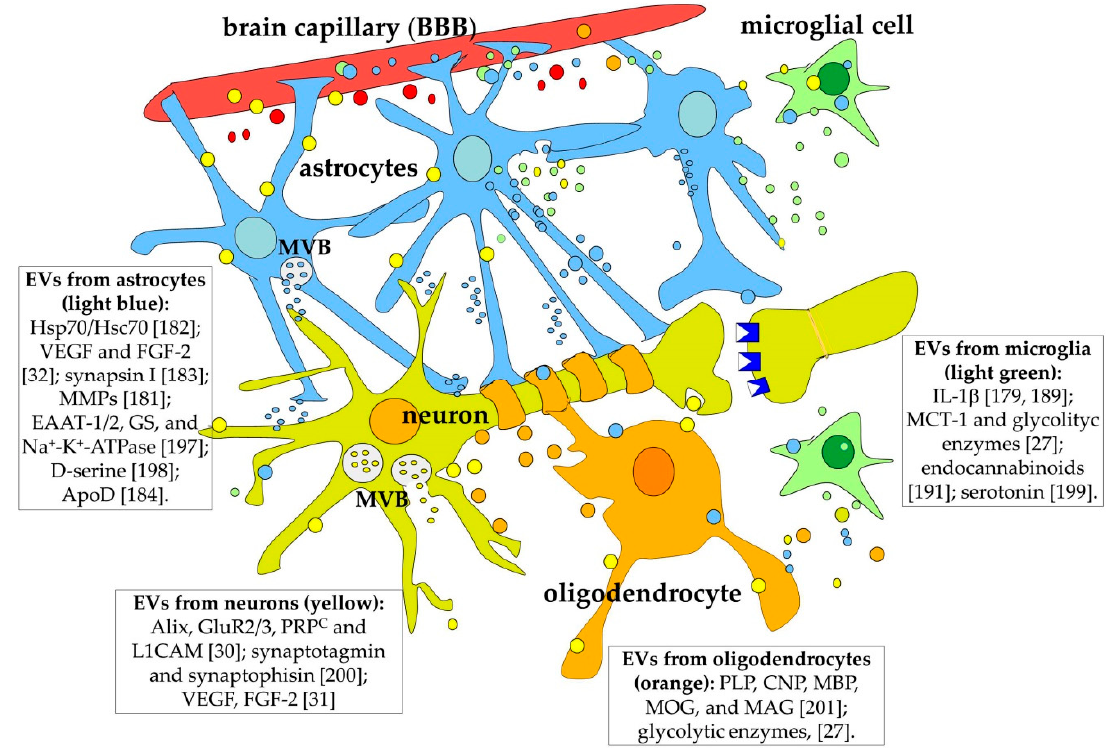
Figure 6. All the cell types in the CNS release EVs of different size, origin, and composition. For clarity, both larger and smaller vesicles have been coloured the same colour as the producing cell. A few components of the vesicles are reported in the inserts with the relevant references [27,31,179,182–184,189,197–201]. Abbreviations: ApoD, apoprotein D; BBB, blood–brain barrier; CNP, 2 (cid:48) ,3 (cid:48) -Cyclic Nucleotide 3 (cid:48) Phosphodiesterase; EAAT, excitatory amino acid